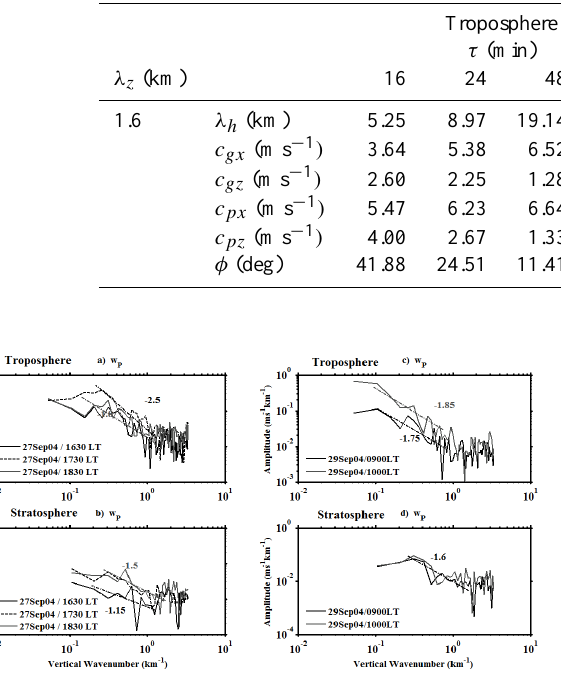
Figure 10. Vertical wavenumber spectra of gravity waves for the fluctuations of vertical velocity 745 Fig. 10. Vertical wavenumber spectra of gravity waves for the fluc- in the troposphere (4-15 km) (a) for 27 September 2004 at 16:30 LT (black), 17:30 LT (dashed 746 tuations of vertical velocity in the troposphere (4–15km) (a) for 27 September 2004 at 16:30LT (black), 17:30LT (dashed black), black), 18:30 LT (gray) and (c) for 29 September 2004 at 09:00 LT (black) and 10:00 LT (gray), 747 18:30LT (gray) and (c) for 29 September 2004 at 09:00LT (black) respectively, and, (b and d) for the lower stratospheric region, respectively. The dashed lines in 748 and 10:00LT (gray), respectively, and (b and d) for the lower strato- black and gray colors represent the model slope fitting. 749 spheric region, respectively. The dashed lines in black and gray col- ors represent the model slope